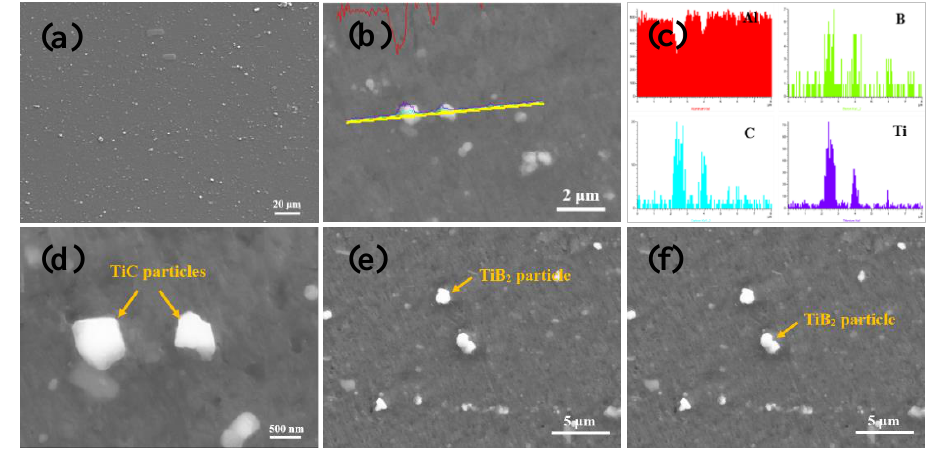
Figure 1. ( a ) Morphology of Al-Ti-C-B master alloy, ( b – d ) TiC particles, ( e – f ) TiB 2 particles.